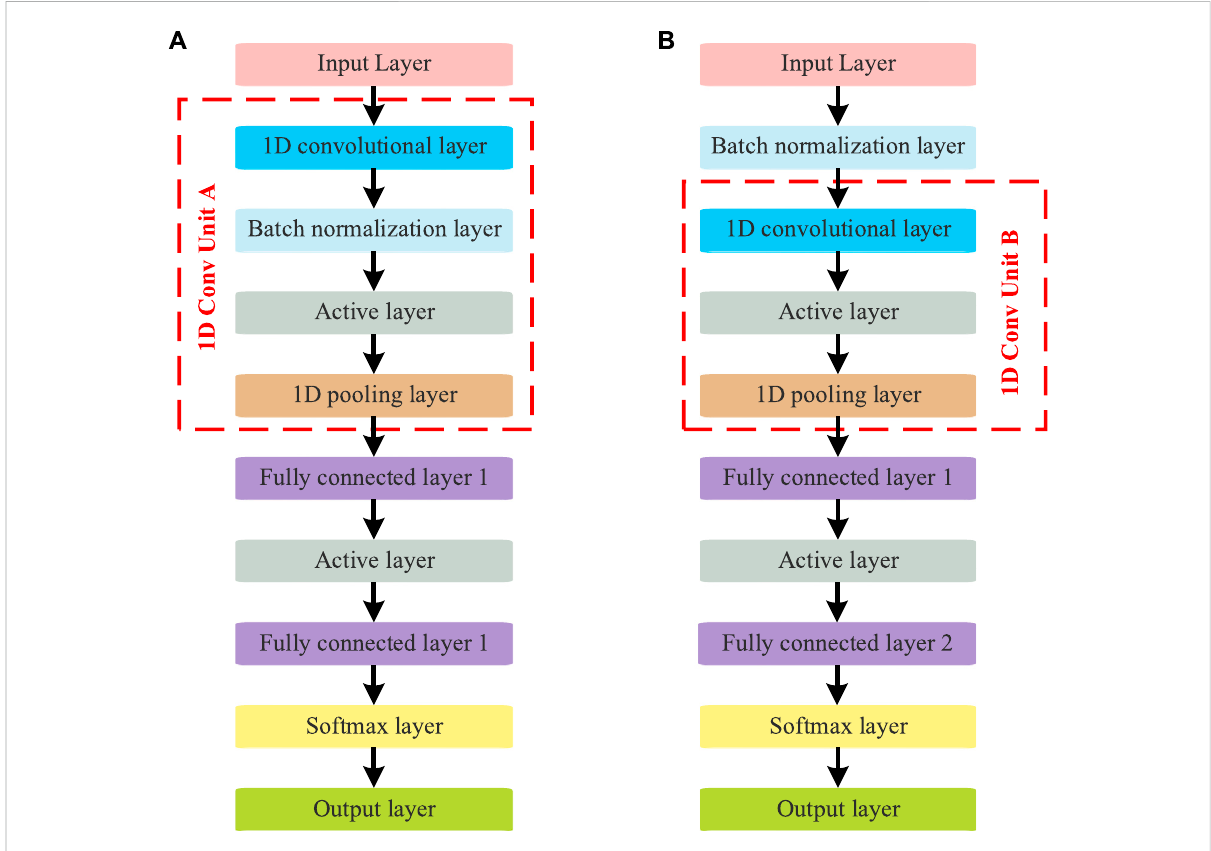
FIGURE 4 Structure of the commonly used 1D-CNN. (A) 1D-CNN-A, and (B) 1D-CNN-B.